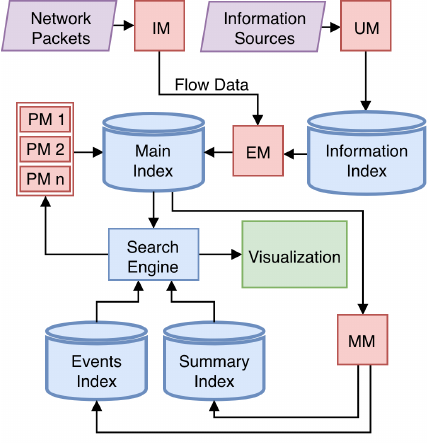
Figure 2. System